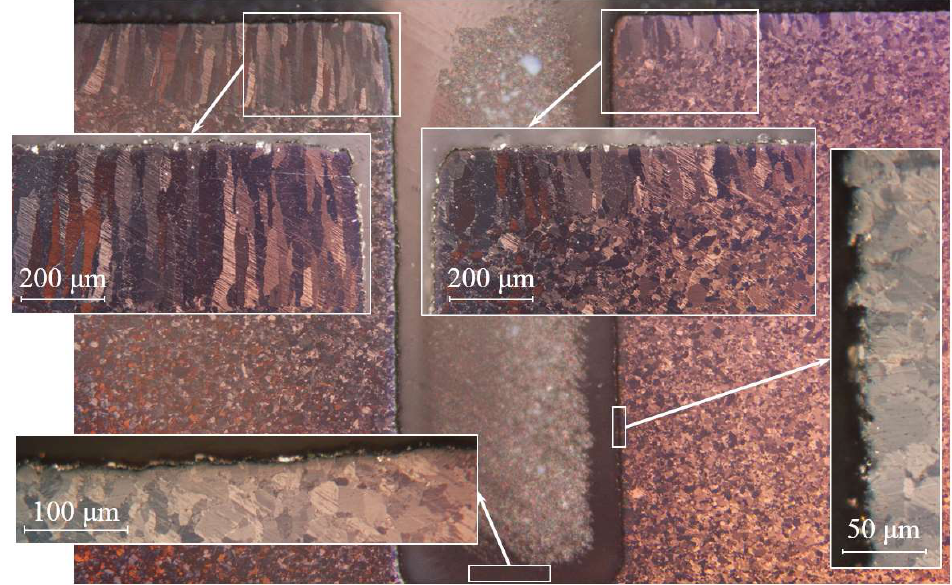
Figure 12. Microstructure of the Be-3 sample cross section (800 °С, 100 cycles). As can be seen in Figure 13, the concentration of pores in sections 1 and 2 of sample Be-3 is the same; and the average value of the pore diameter in these sections is about 20 µm. In the area remote from the center of the sample (Figure 13, section 3), the concentration and the average value of the pore diameter decrease by 10 µm. The surface of the matrix is covered with a fine structure. The working surface has a light gray shade and a slight change in shape in the central part.